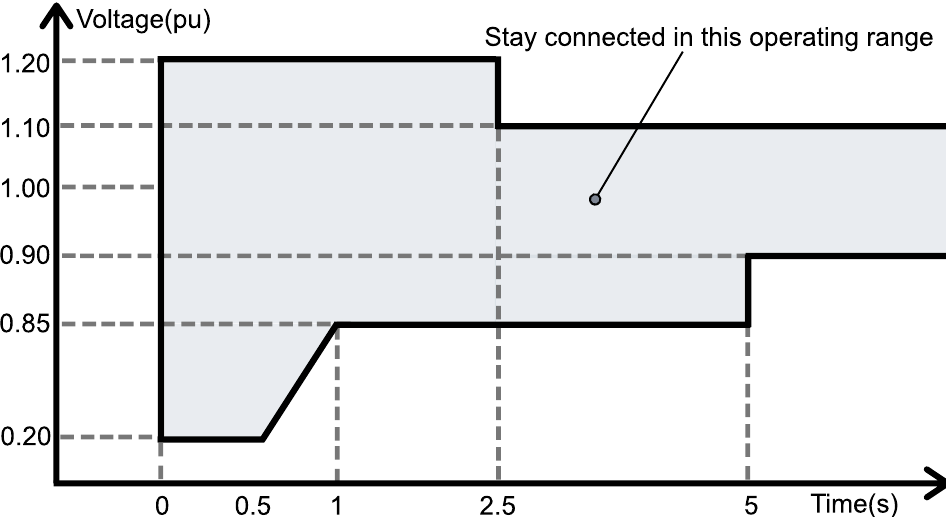
Figure A3. Supportability curve for transient undervoltage and overvoltage LVRT [38]. Table A10. System frequency limits in case of perturbation.